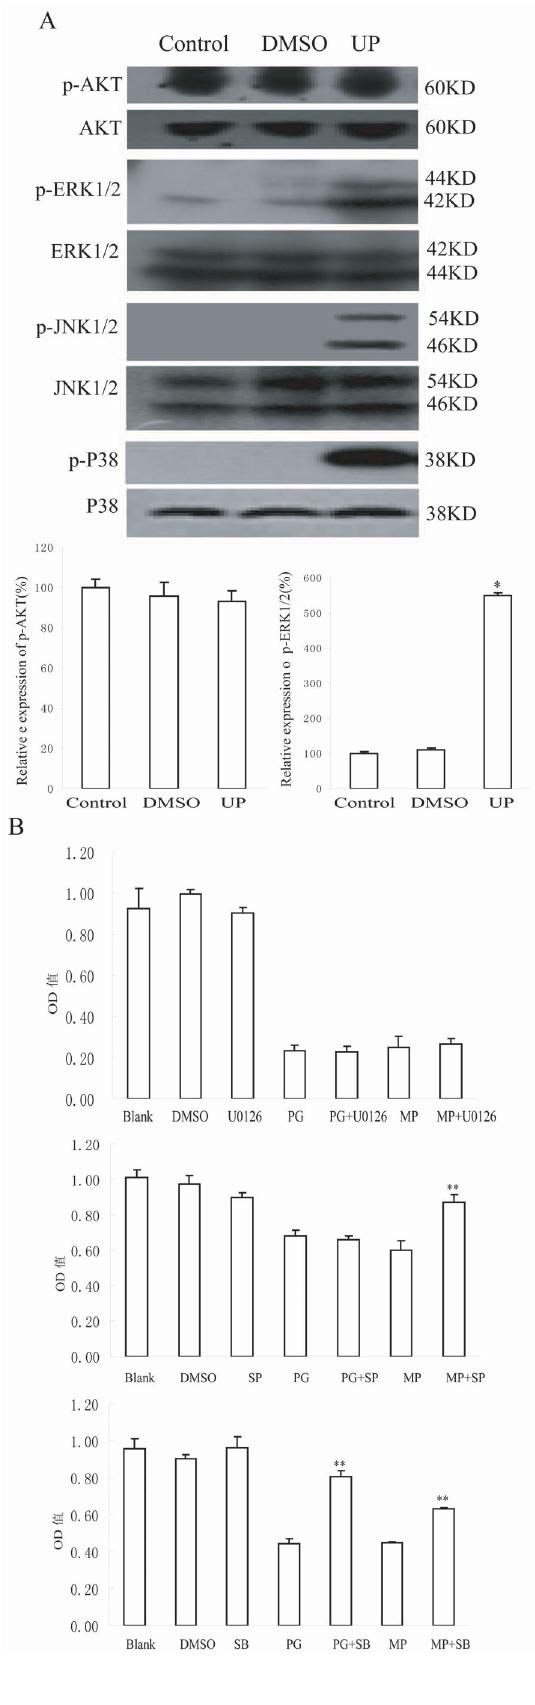
Figure 5. Activated protein kinases related to UP induced apoptosis. A . Effects of exposure of P388 cells to 0.05 m M UP for 1 h on the phosphorylation status and expression level of protein kinases. The expression was quantified using the computerized image analysis system ImageQuant. Each column represents those scanned in duplicate of three wells expressed as percentage of control 6 Standard Deviation. ***, P , 0.001, UP vs. Control. B . Effects of MAPK inhibitors on UP-induced P388 growth inhibition,the cells were pretreated